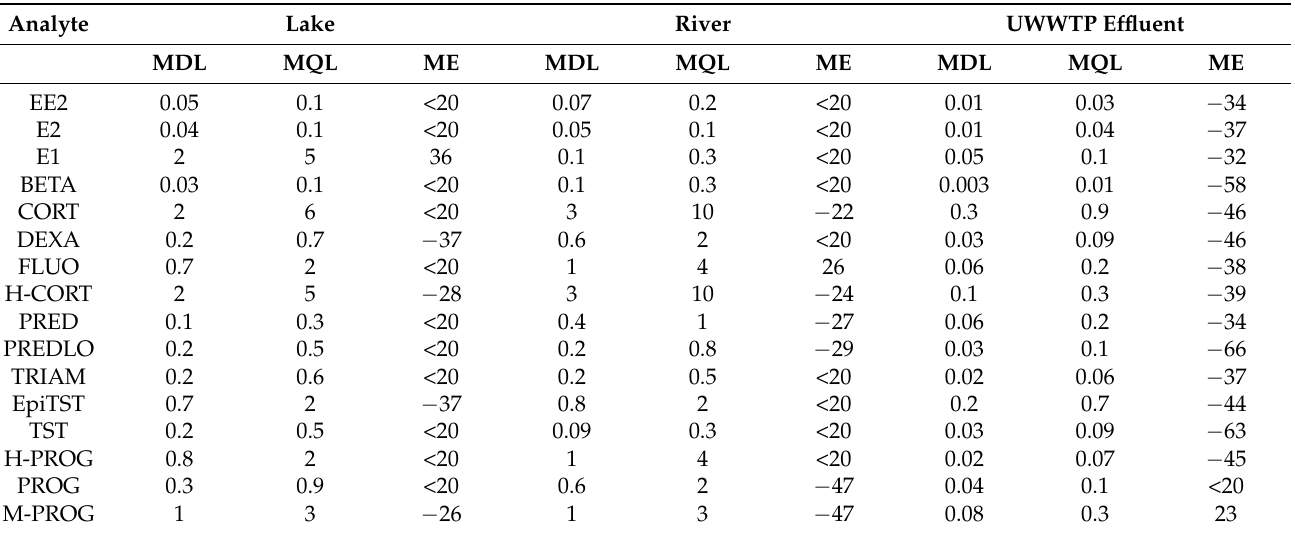
Table 3. ME (%) and calculated MDL and MQL values (ng L − 1 ) from each matrix-matched calibration curve, taking into consideration the whole sample treatment.